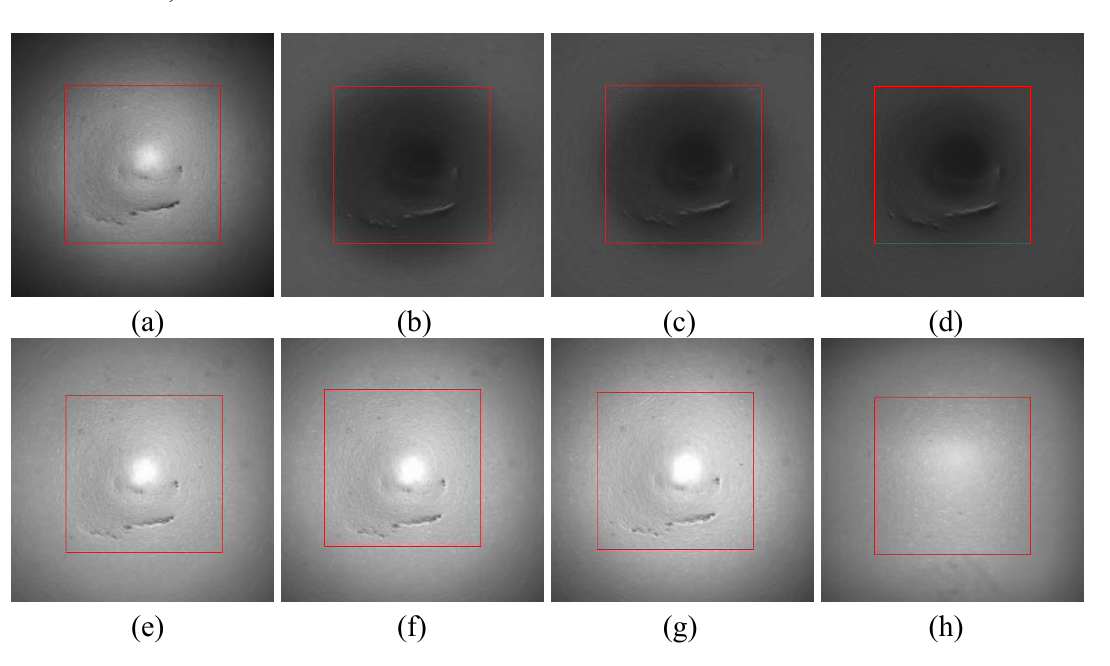
Figure 10. Gray scale image of target region: (a) coaxial light only, (b) , (c) , (d) ring light only, L is 35 mm, 40 mm, 45mm in turn, (e) , (f) , (g) combining light, L is 35 mm, 40 mm, 45 mm in turn, (h) no defect.